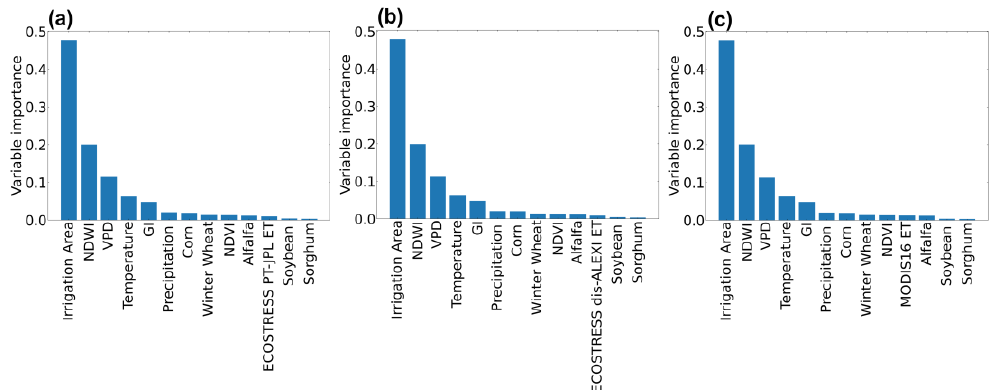
Figure 7. Input variable importance scores calculated by the RFR (averaged from 200 times of re-